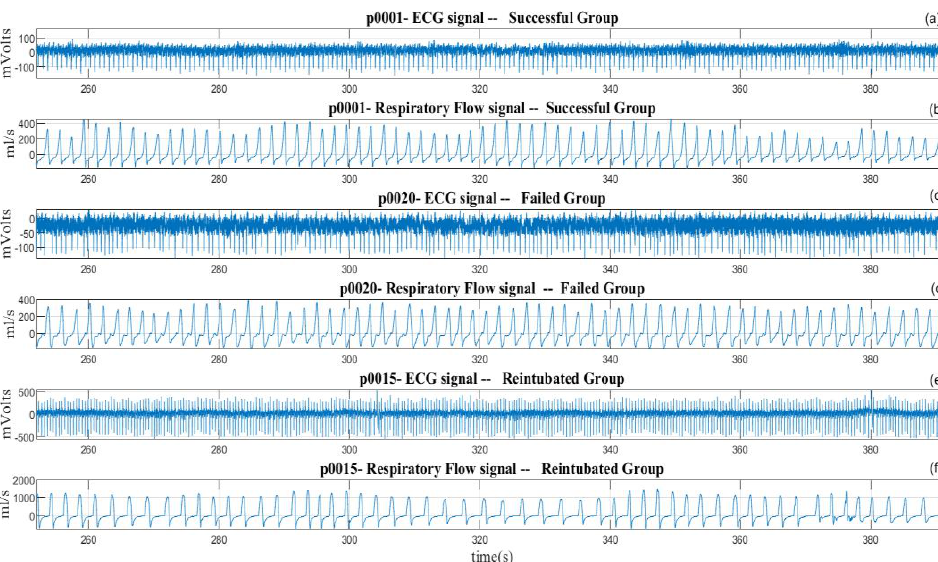
Figure 1. Excerpt of ECG and respiratory flow signals from patients undergoing extubation process of ( a , b ) a patient from the successful group, ( c , d ) a patient from the failed group, and ( e , f ) a patient from the reintubated group.